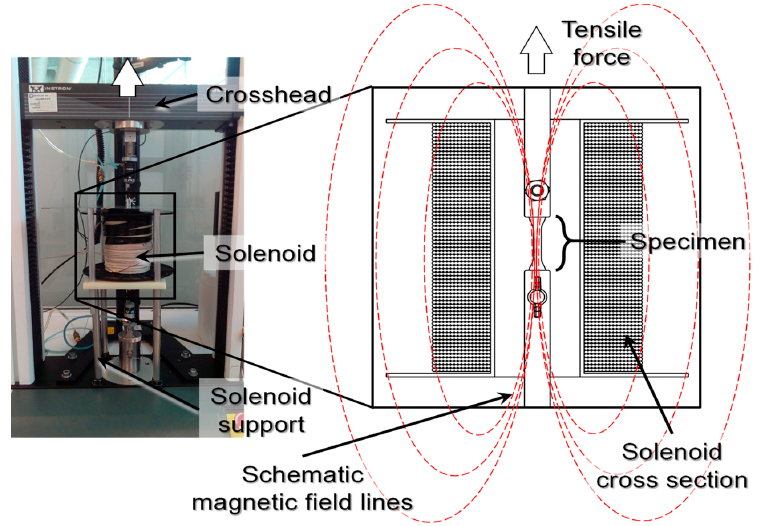
Figure 4. Tensile test set up and its schematic magnetic field applied on the magnetorheological elastomer (MRE) samples, according to the solenoid design and desire experimental measurements. The maximum magnetic field variation along the specimen is only 4% due to the solenoid length relative to the tensile sample material length. Additionally, the experimental set up allows the magnetic field lines to be parallel to the micro particle arrangement inside the material sample.